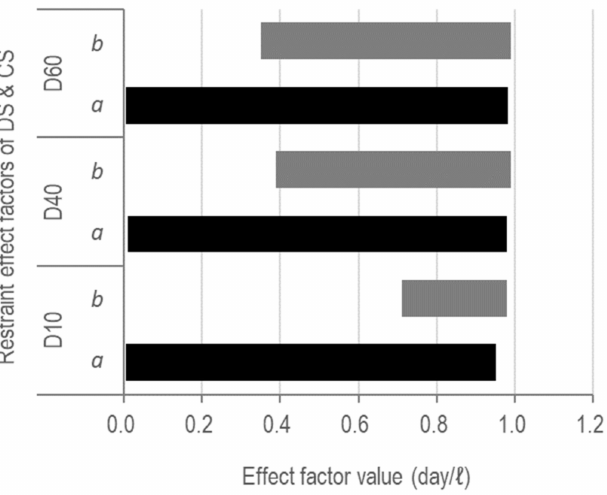
Figure 15. Analysis results of restraint effect factor of DS and CS (W170 mixtures); a is the restraint effect factor of DS and b is the restraint effect factor of CS.